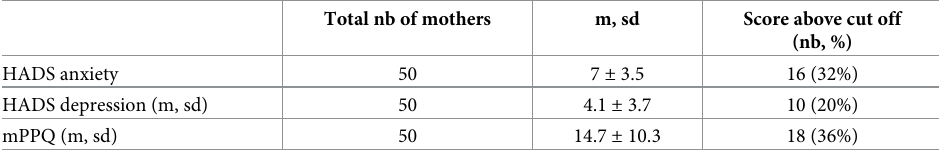
Table 3. Psychological assessment results for mothers 18 months after birth (during visit